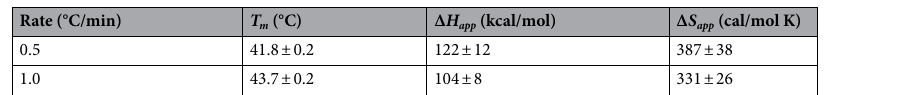
Table 1. Thermodynamic parameters of nsP4-CHIKV unfolding by CD spectroscopy. The T m and the Δ H app were determined by fitting the CD data to a two-state equilibrium model 28 . The Δ S app of the unfolding transition at T m was calculated as Δ S app = Δ H app / T m since Δ G = 0 at T m .